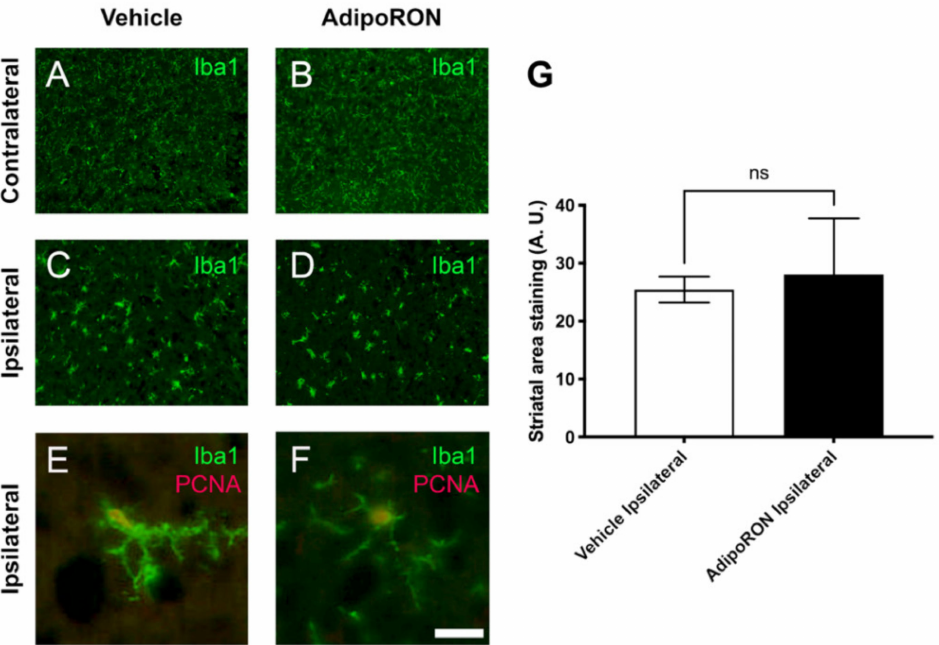
Figure 7. AdipoRON has no effect on the infarct size and on the number of activated caspase 3-positive cells 24 h post-stroke. ( A – D ) Iba1 immunostaining (green) in the contralateral ( A , B ) and ipsilateral ( C , D ) hemispheres of Vehicle and AdipoRON-injected mice. ( E , F ) Iba1 and PCNA co-stainings showing proliferation of microglia in the ipsilateral hemisphere of Vehicle and AdipoRON-treated mice (yellow). ( G ) Quantification of Iba1-positive staining in the striatal area of the ipsilateral hemispheres showing no difference between both groups. A.U. = Arbitrary Unit. Scale bar = 7 µ m ( E , F ), 200 µ m ( A – D